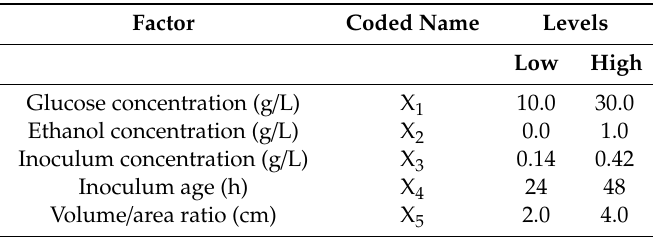
Table 1. Factor levels evaluated in the screening design.